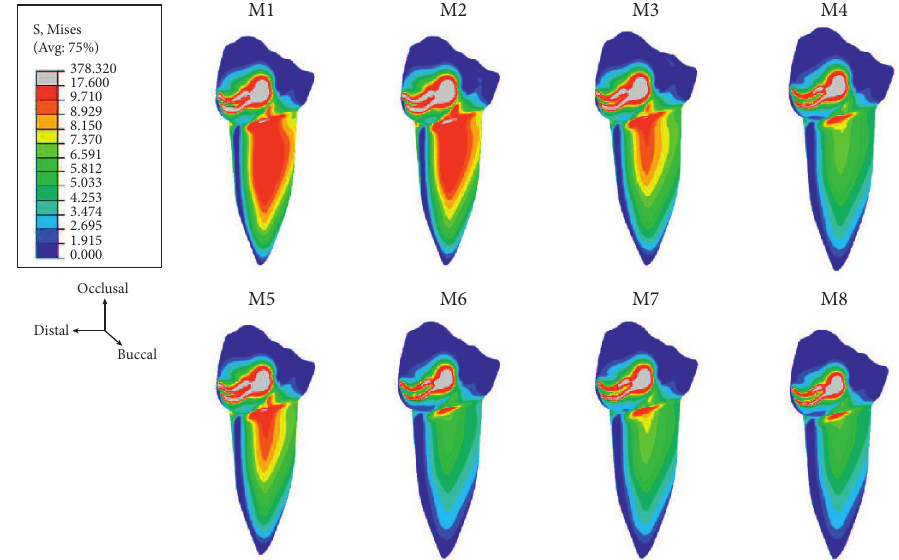
Figure 4: Stress distribution on the distal surface of abutment tooth’s